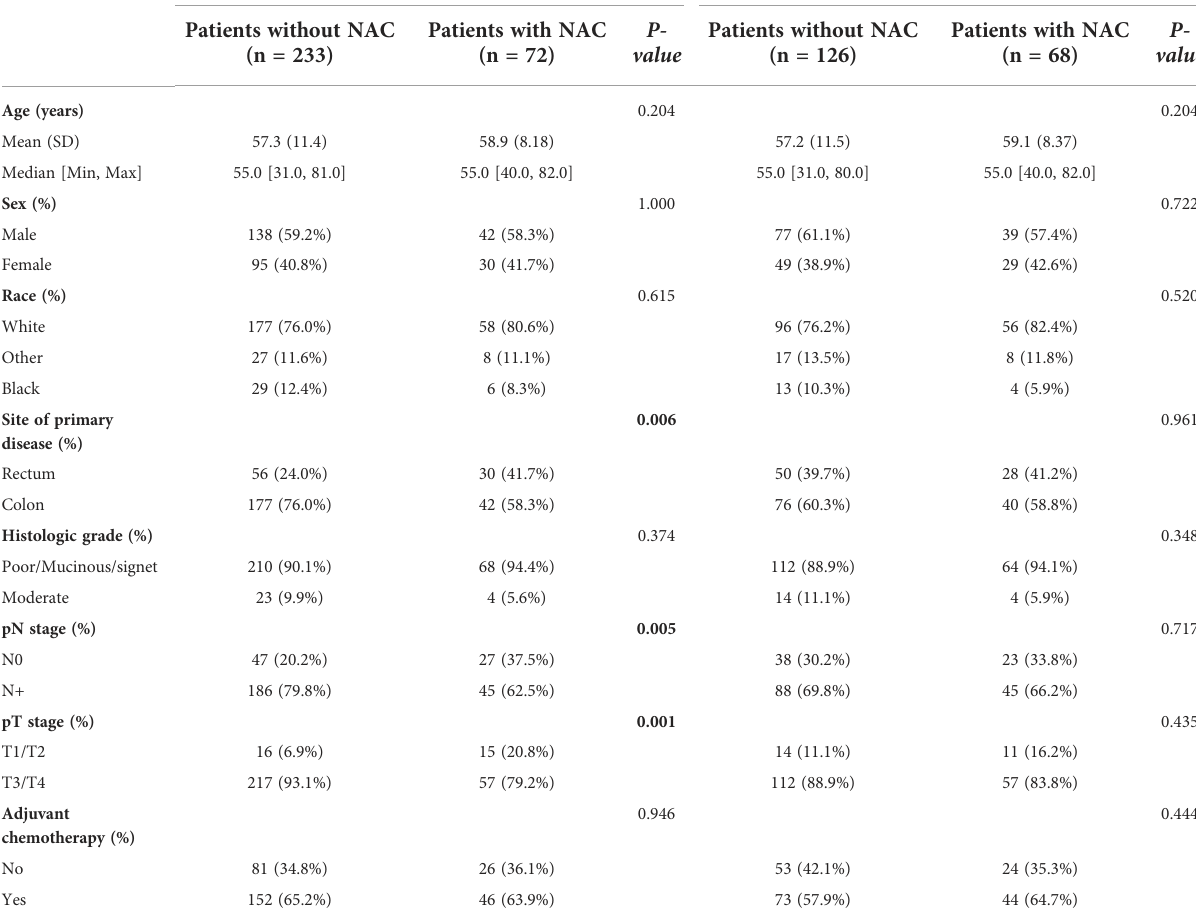
TABLE 2 Baseline clinical characteristics of SEER cohort.